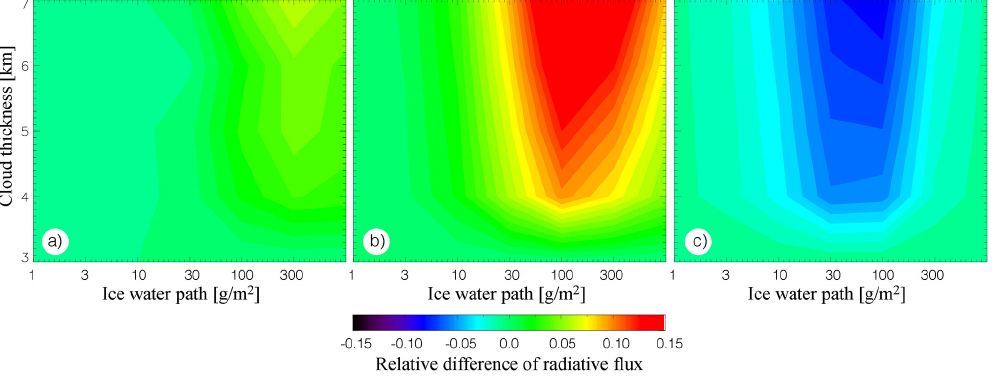
Figure 8. The relative difference in calculated TOA_LW fluxes with respect to rectangular IWC( z ) profile type estimated for 3 to 7km thick clouds with average De = 50µm ( k AB = 1.5, see Sect. 3.3) and with a cloud top at 15km: (a) isosceles trapezoid; (b) lower triangles; (c) upper